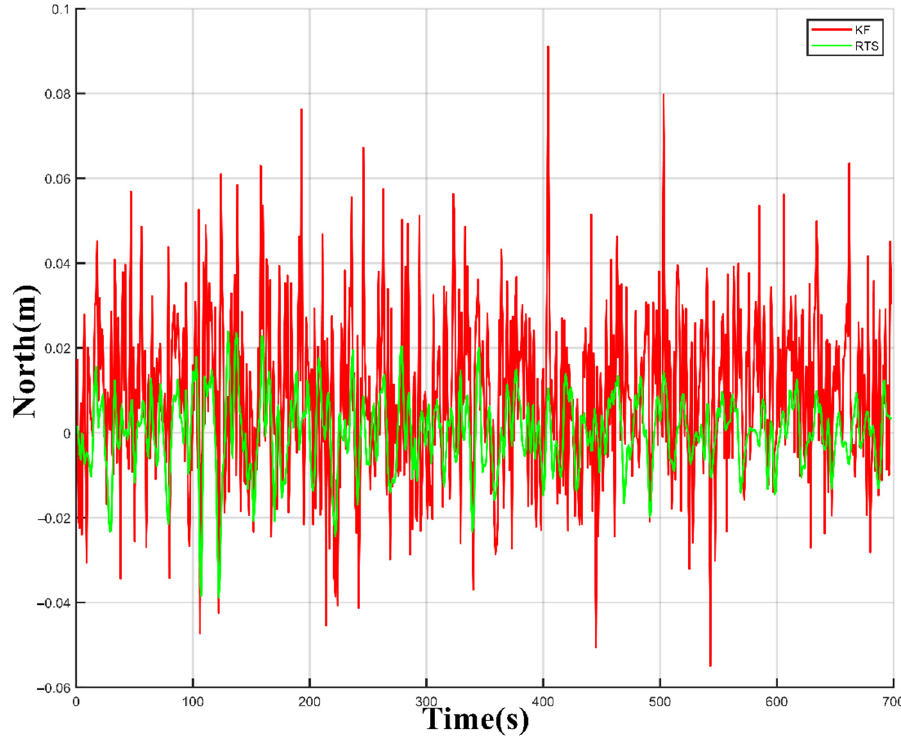
Figure 14. Comparison of northward error between the KF and RTS.